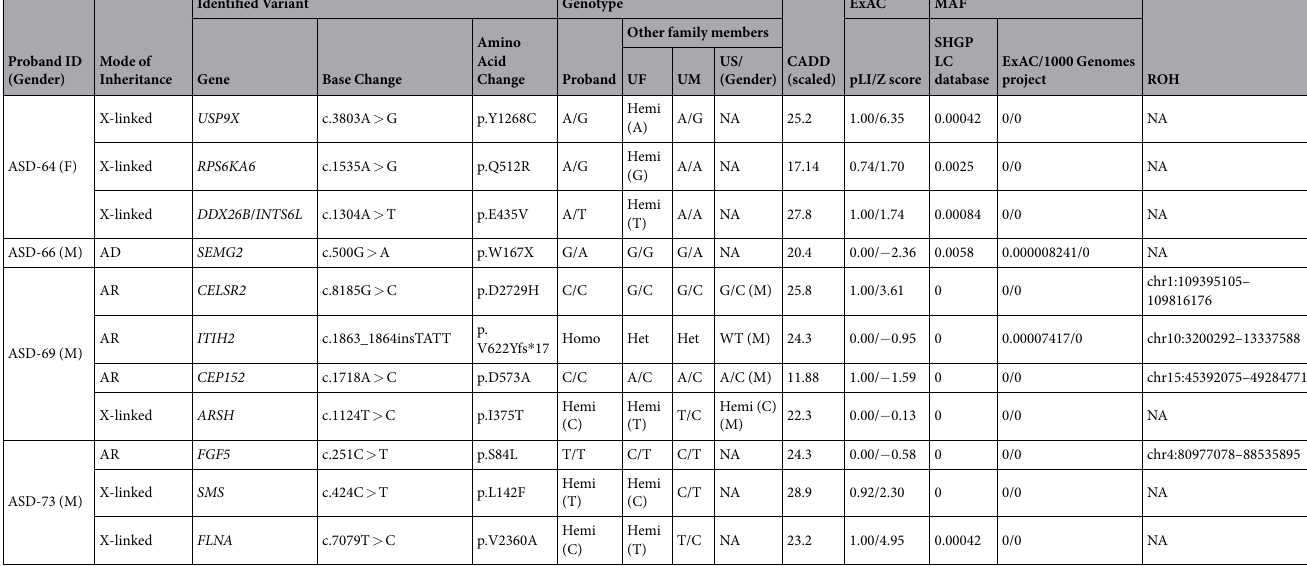
Table 2. Rare variants identified in each trio. # PredictSNP2 score for splice site variants is “Deleterious”